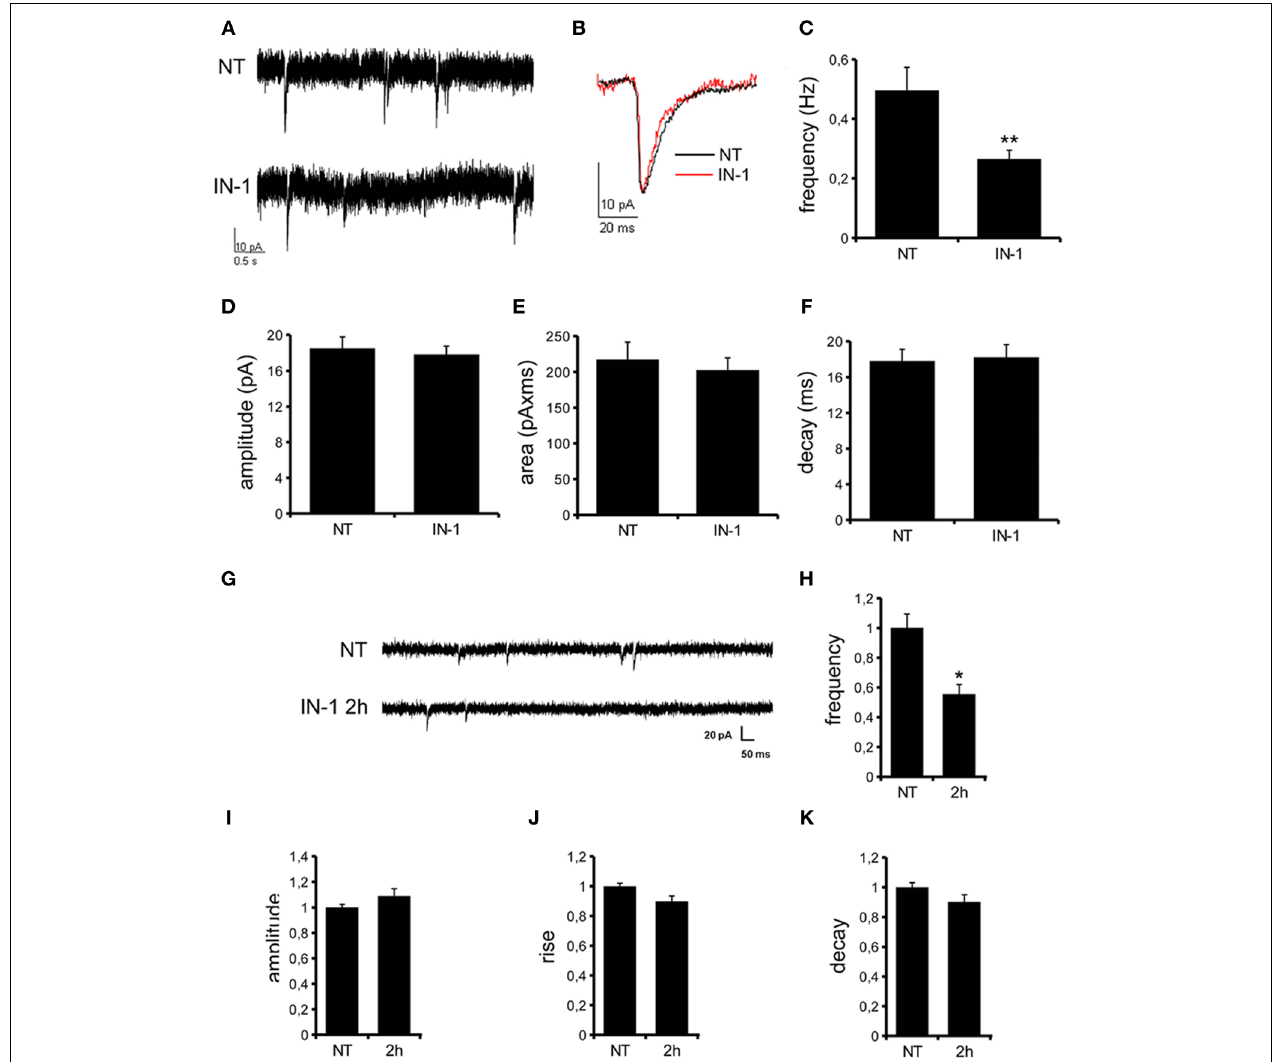
(G) Representative traces of mEPSCs from hippocampal culture at DIV12-13 under control condition (NT) or after incubation with IN-1 (2 µ M) for 2h. IN-1 pretreatment reduces mEPSC frequency (H) , but not amplitude (I) , rise (J) or decay (K) time. Data were normalized on not treated condition and expressed as mean ± s.e.m.; ∗ p < 0 . 05 vs. not treated, n = 14, ANOVA followed by Dunn’s post-hoc